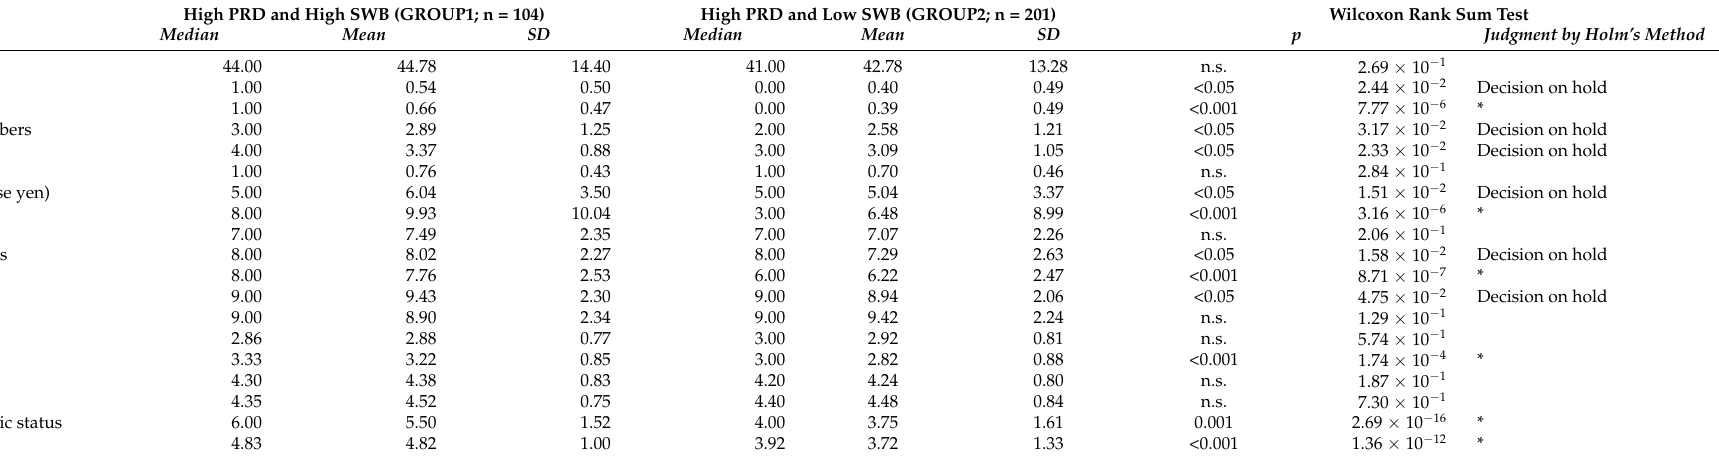
Table 5. Comparison of variables between the group with high PRD and high subjective well-being (GROUP1) and the group with high PRD and low subjective well-being (GROUP2) †. High PRD and High SWB (GROUP1; n = 104) High PRD and Low SWB (GROUP2; n = 201) Wilcoxon Rank Sum Test Variables